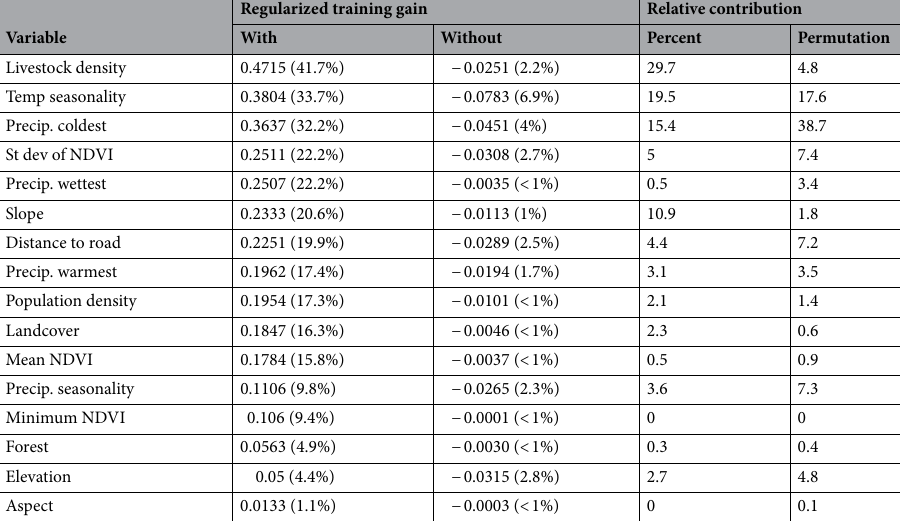
Table 3. Relative importance of variables (n = 16) to the modelling of the Egyptian vulture’s global distribution. Variables are ranked according to four measures of variable importance: (1) jack-knife test of regularized training gain for predicting the distribution of the occurrence data using only that variable (‘with’), presented as both the raw gain value and as a percentage of the model containing all variables (gain = 1.13), (2) loss of regularized training gain from a jack-knife test comparing the model containing all variables, and a model with that variable excluded (‘without’), (3) the percent contribution of each variable in the model training algorithm (‘percent’), and (4) the permutation importance of each variable as measured by AUC and normalized to a percentage (‘permutation’). See Appendix 1 for additional jack-knife plots of training gain, test gain and AUC.